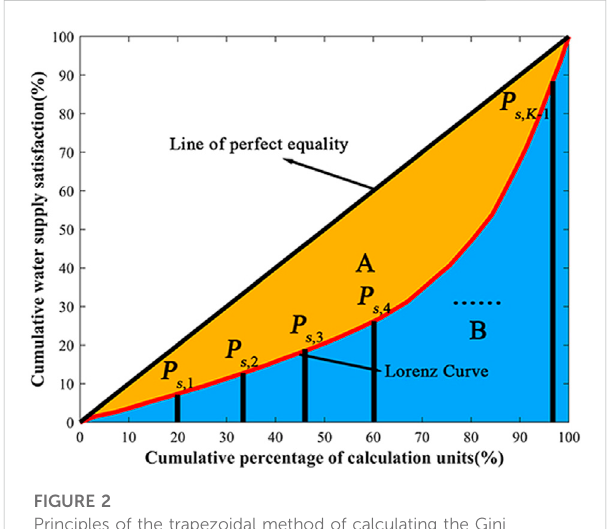
FIGURE 2 Principles of the trapezoidal method of calculating the Gini coef fi